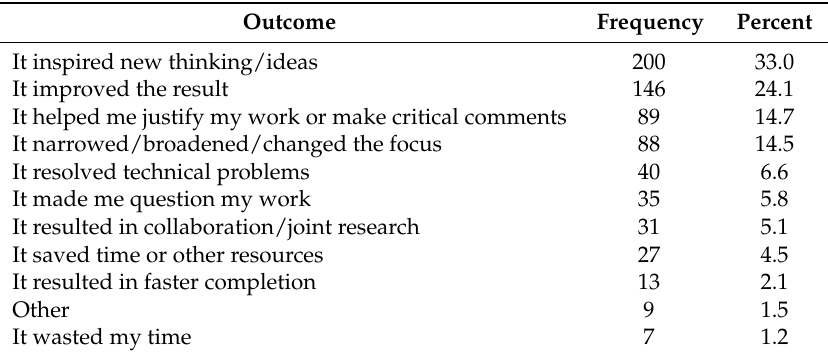
Table 25. Outcomes of article reading.